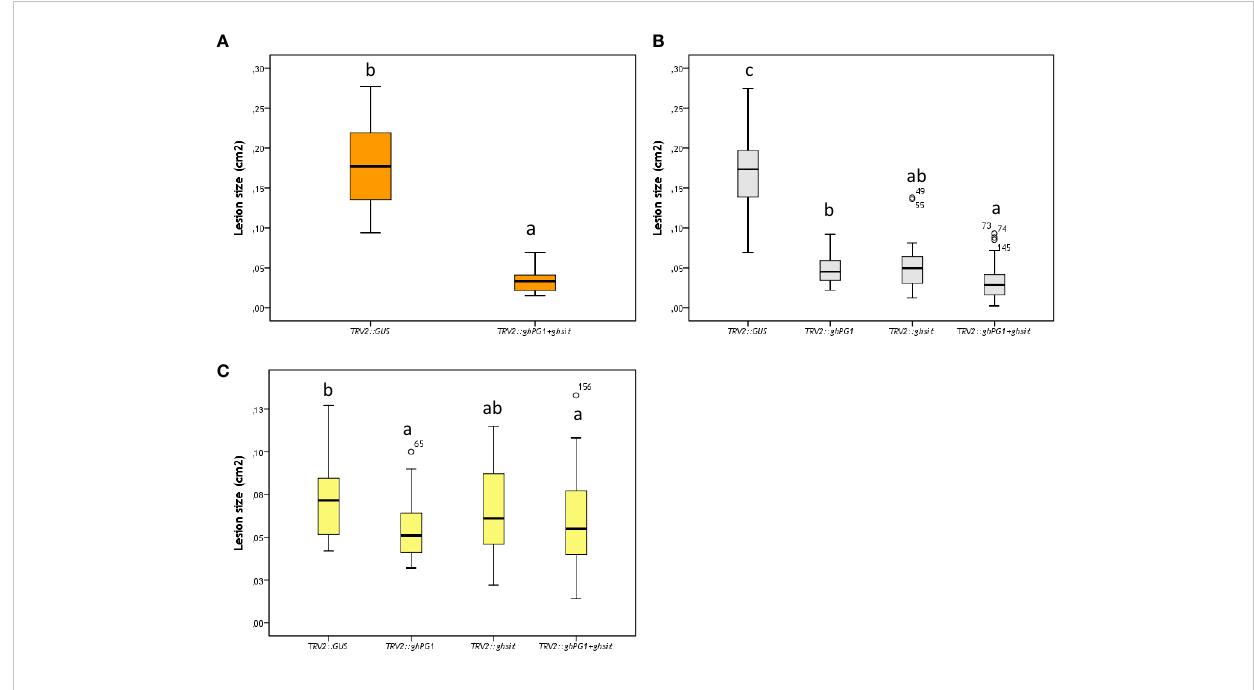
FIGURE 3 The lesion size (cm2) of Botrytis inoculation at 24hpi on different ray fl orets of parental silenced plants. (A) SP1; (B) SP2; (C) FP1. Different letters indicate signi fi cant difference (P<0.05). Every single ray fl oret for ImageJ measurement was coded with a number, and ray fl orets with number such as 49, 55, 73, 74 etc were indicated the outliers of